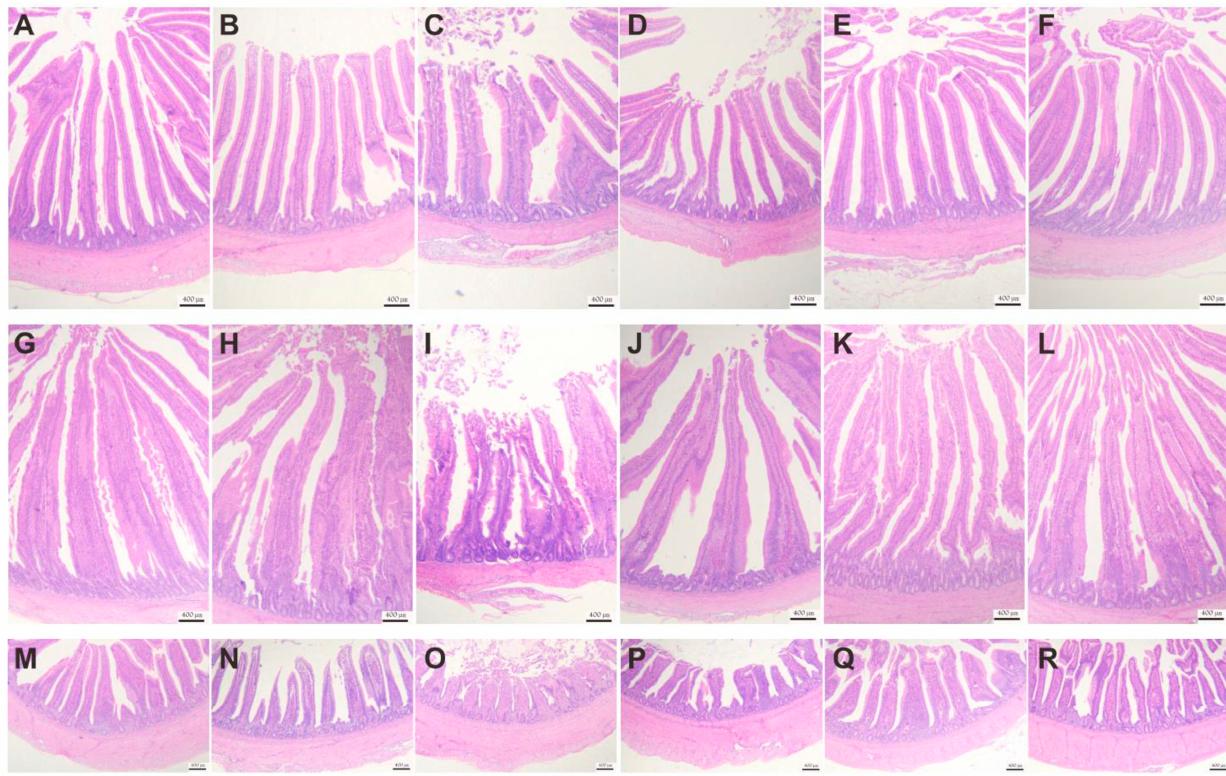
Figure 3. Effects of different levels of VD 3 supplementation on the intestinal morphology of the Wenchang chicken oxidative stress model (40 × ). ( A – F ): jejunum morphology. ( A ) CK group, ( B ) 4000VD group, ( C ) DI group, ( D ) 1000VD+DI group, ( E ) 2000VD+DI group, ( F ) 4000VD+DI group. ( G – L ): duodenal morphology. ( G ) CK group, ( H ) 4000VD group, ( I ) DI group, ( J ) 1000VD+DI group, ( K ) 2000VD+DI group, ( L ) 4000VD+DI group. ( M – R ): ileum morphology. ( M ) CK group, ( N ) 4000VD group, ( O ) DI group, ( P ) 1000VD+DI group, ( Q ) 2000VD+DI group, ( R ) 4000VD+DI group.